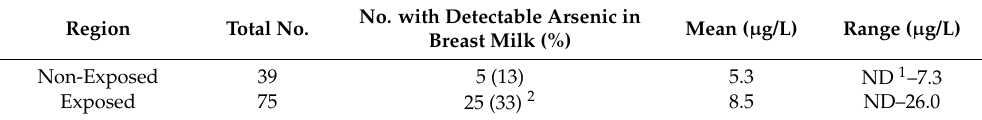
No. with Detectable Arsenic in Mean ( µ g/L) Range ( µ g/L) Breast Milk (%)